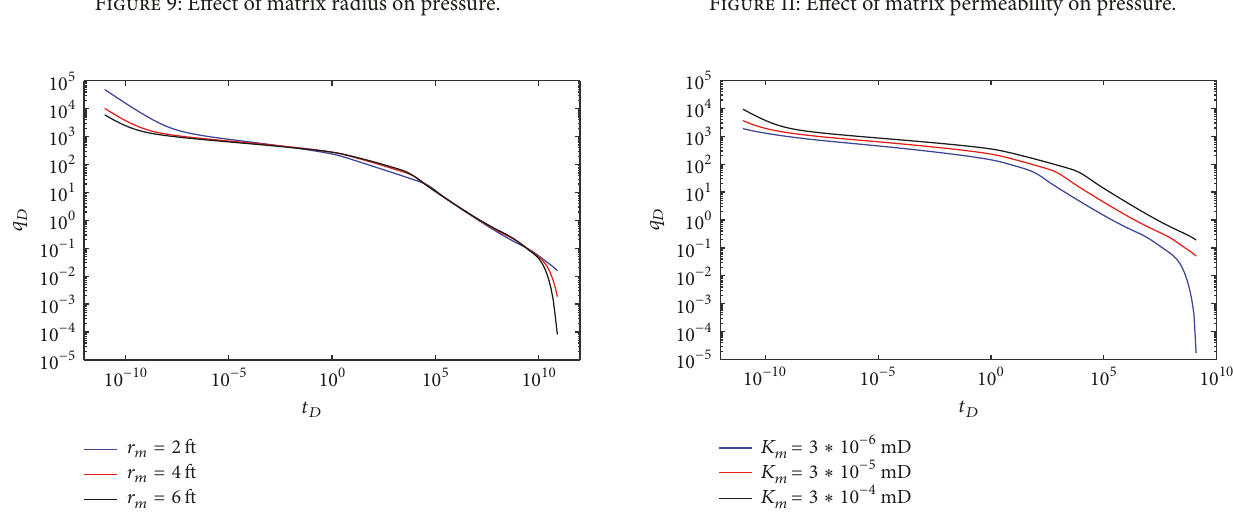
Figure 9: Effect of matrix radius on pressure.